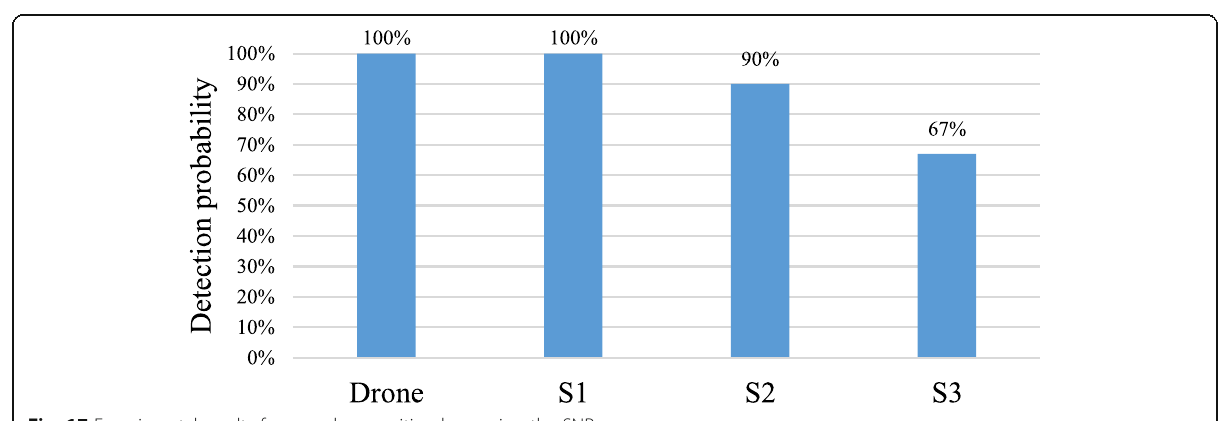
Fig. 17 Experimental results for sound recognition by varying the SNR